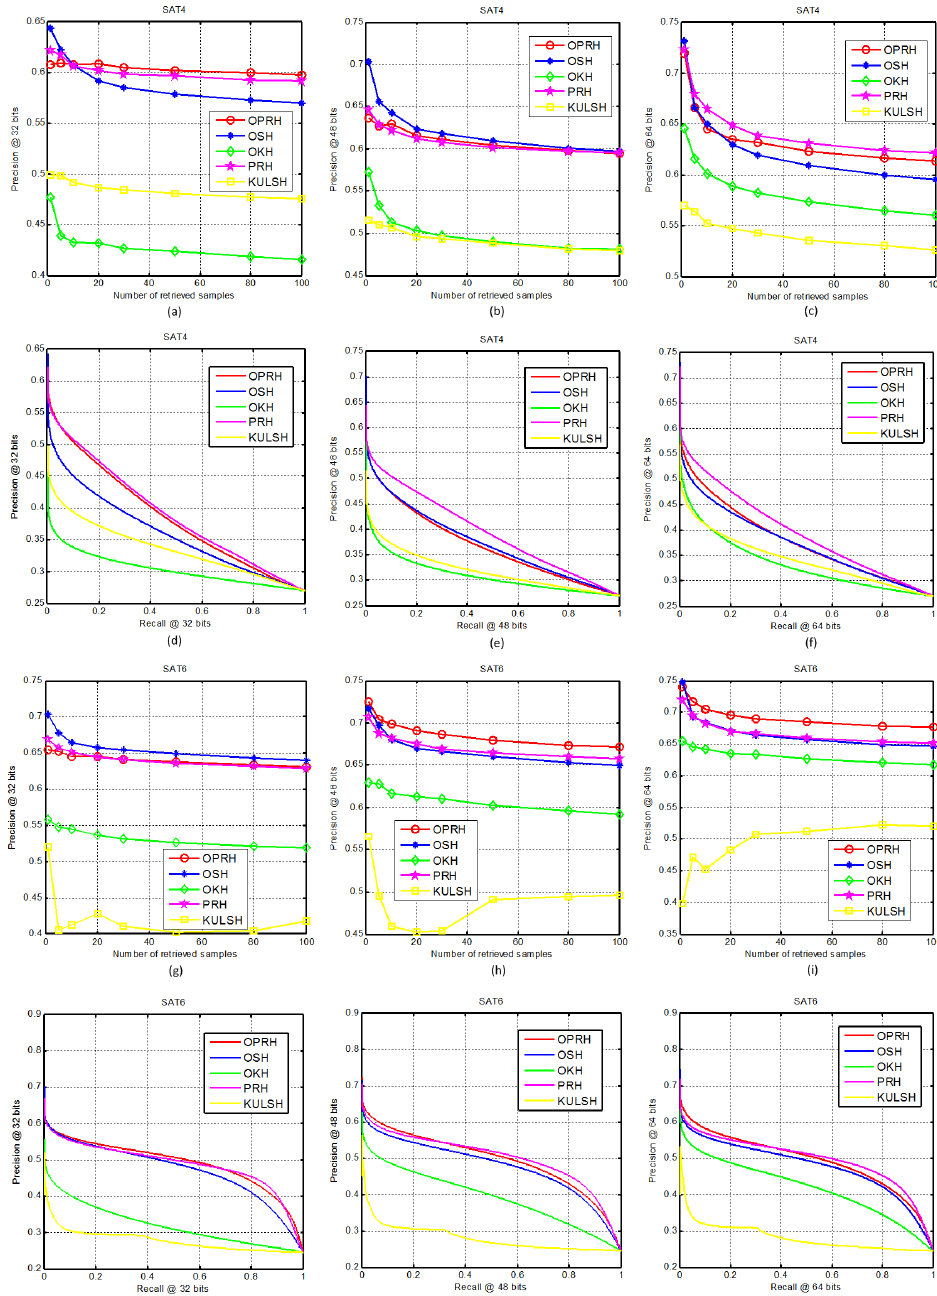
Figure 3. The average precision with respect to different retrieved samples and precision-recall curves for the compared methods on the two datasets: ( a–f ) SAT-4; and ( g–l ) SAT-6. We also compare the learning efficiency of different hashing methods, which is shown in Table